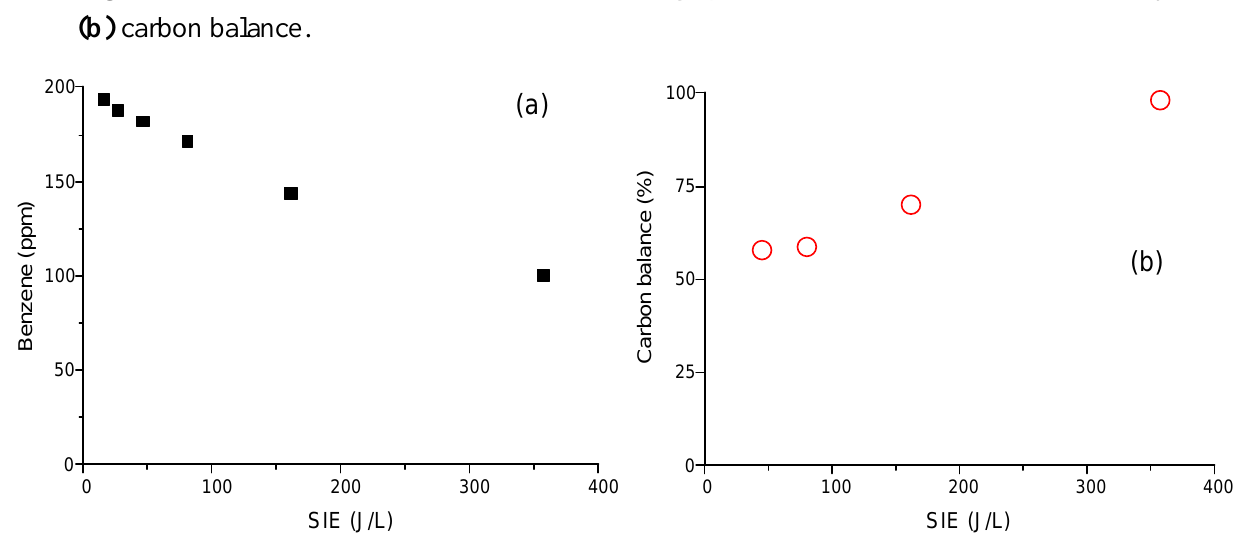
Figure 3. Size distribution of aerosol according to specific input energy to the plasma reactor. (204 ppm benzene in humid